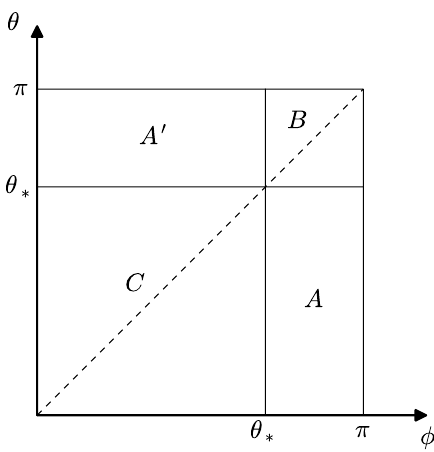
Figure 2 . Division of the integration domain for the double integral in (4.36). On the dashed line, where (cid:18) = (cid:30) , both, the denominator and the logarithm in the integral vanish. where the angle (cid:18) (cid:3)